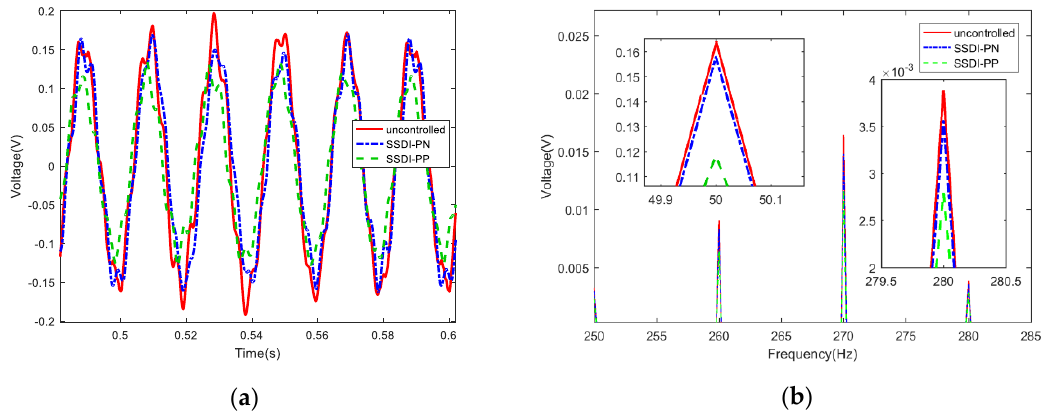
Figure 15. Comparison of damping-effect in three cases (white noise, phase difference: 180 degree): ( a ) displacement response in time domain; ( b ) frequency response. Table 3. Damping comparison of the double-beam system in three cases (white noise, 180 degree).